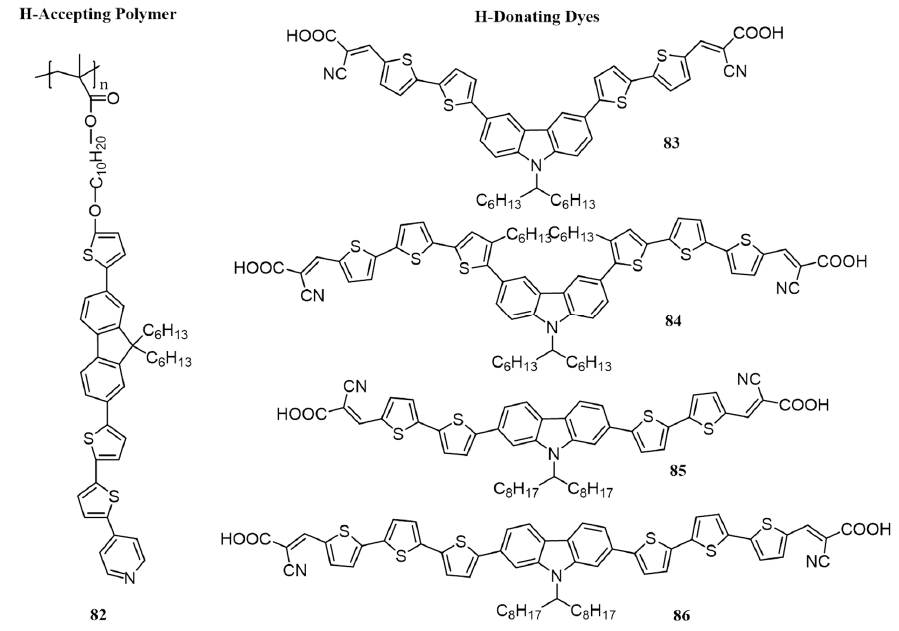
Figure 28. Chemical structures of the H-acceptor side-chain polymer ( 82 ) and H-donor dyes ( 83 – 86 ) synthesized by Lin et al. [96].